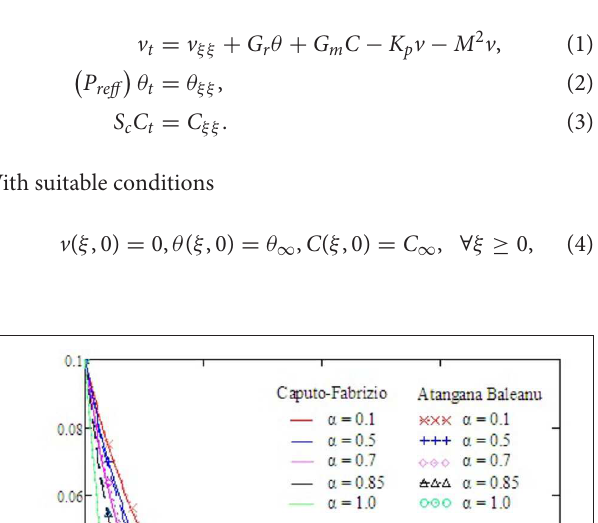
FIGURE 1 | Variations in temperature with altered values of α and other parameters are k p S c 0.5. =